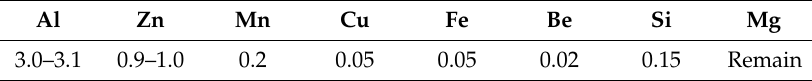
Table 2. Chemical composition of AZ31 (mass fraction